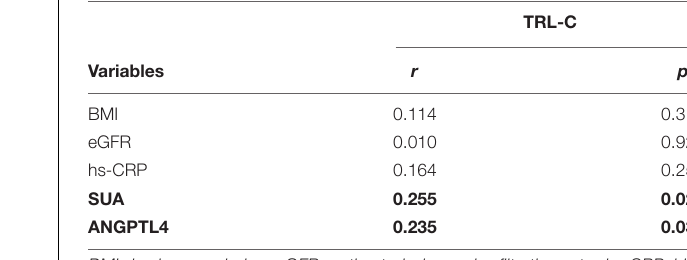
TABLE 5 | Correlation analysis of TRL-C and metabolic factors.